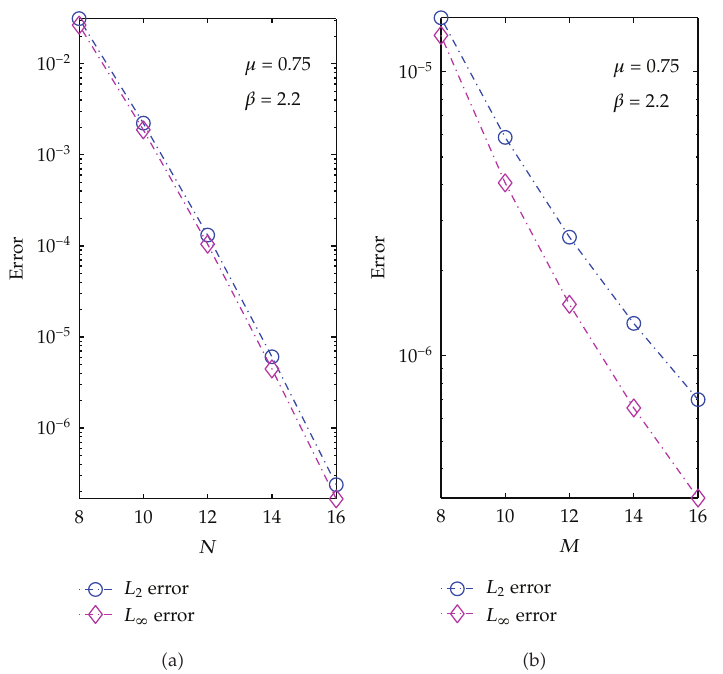
Figure 6: y -axis is log scale. (cid:4) a (cid:5) Errors versus N with M (cid:6) 16 ,μ (cid:6) 0 . 75. (cid:4) b (cid:5) Errors versus M with N (cid:6) 16 ,μ (cid:6) 0 .